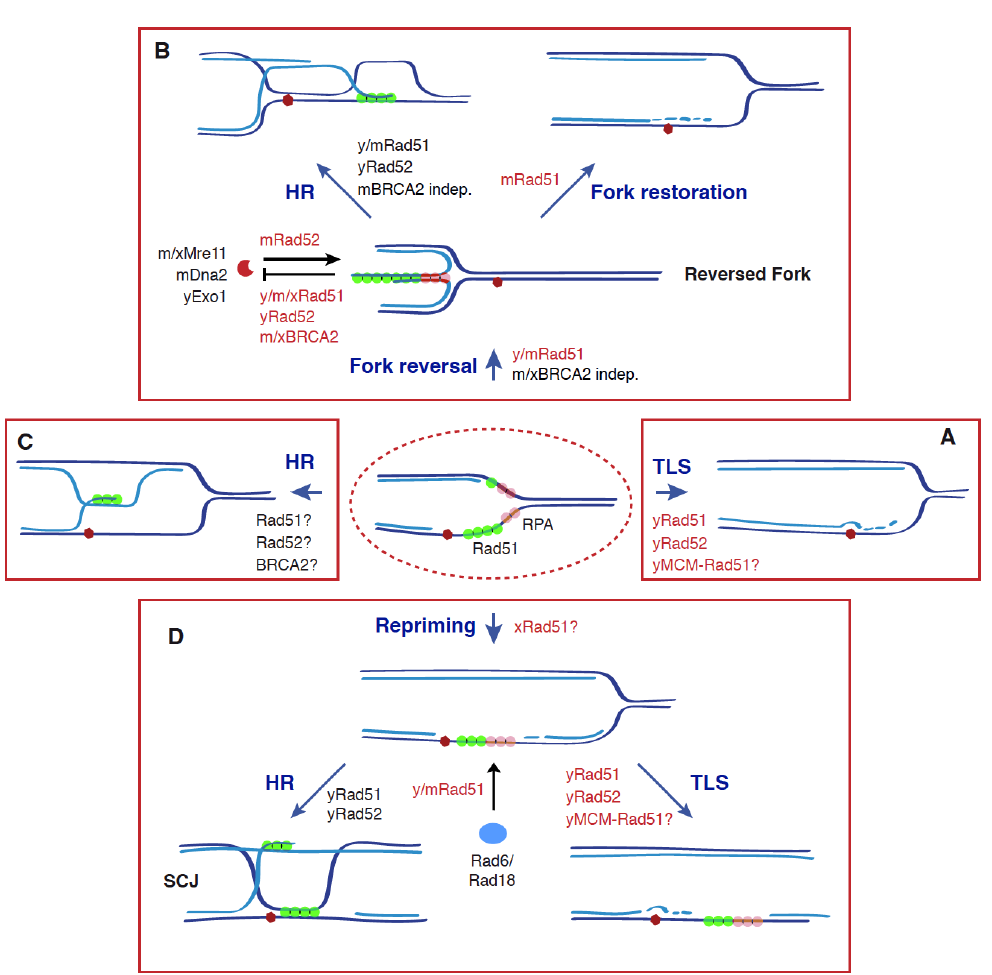
Figure 2. Recombinogenic and non-recombinogenic functions of Rad51, BRCA2, and Rad52 in DDT. The DDT response is triggered by an accumulation of ssDNA at the fork as a consequence of stress conditions (e.g., blocking lesions, dNTP depletion) that uncouple DNA unwinding and DNA synthesis activities. This response is characterized by ubiquitylation of PCNA, which facilitates the bypass of the blocking lesion and the fill in of the ssDNA gaps through different mechanisms: TLS ( A ), fork reversal, followed by HR or fork restoration ( B ), HR ( C ), and repriming, followed by HR or TLS ( D ). Apart from its canonical role in HR by promoting strand exchange, Rad51 plays additional, non-recombinogenic roles together with BRCA2 and Rad52 in (1) the formation, protection, and restart of reversed forks through Rad51 nucleofilaments; (2) TLS, by facilitating Rad6/Rad18 recruitment to chromatin and subsequent PCNA ubiquitylation, and by physically interacting with the helicase MCM at nucleoprotein scaffolds. All these functions make Rad51 a potential molecular switch to choose the DDT mechanism. See text for more details. Dark and light blue indicate parental and nascent strands; a red hexagon indicates a blocking DNA lesion; non-recombinogenic functions of Rad51, Rad52, and BRCA2 are highlighted in red; y (yeast), m (mammal), and x (Xenopus) indicate the species in which those molecular functions have been shown for each protein; a question mark indicates a putative function.